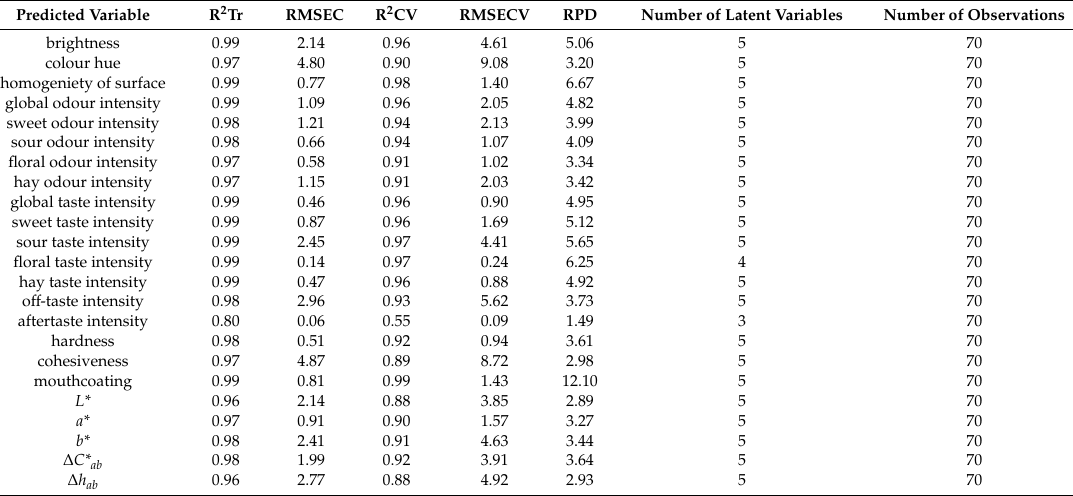
Table 9. Results of the regression models built on the properties of sensory profile analyses and colour parameters of pollen samples based on data of the fusion of NIR, EN, and ET. Predicted Variable R 2 Tr RMSEC